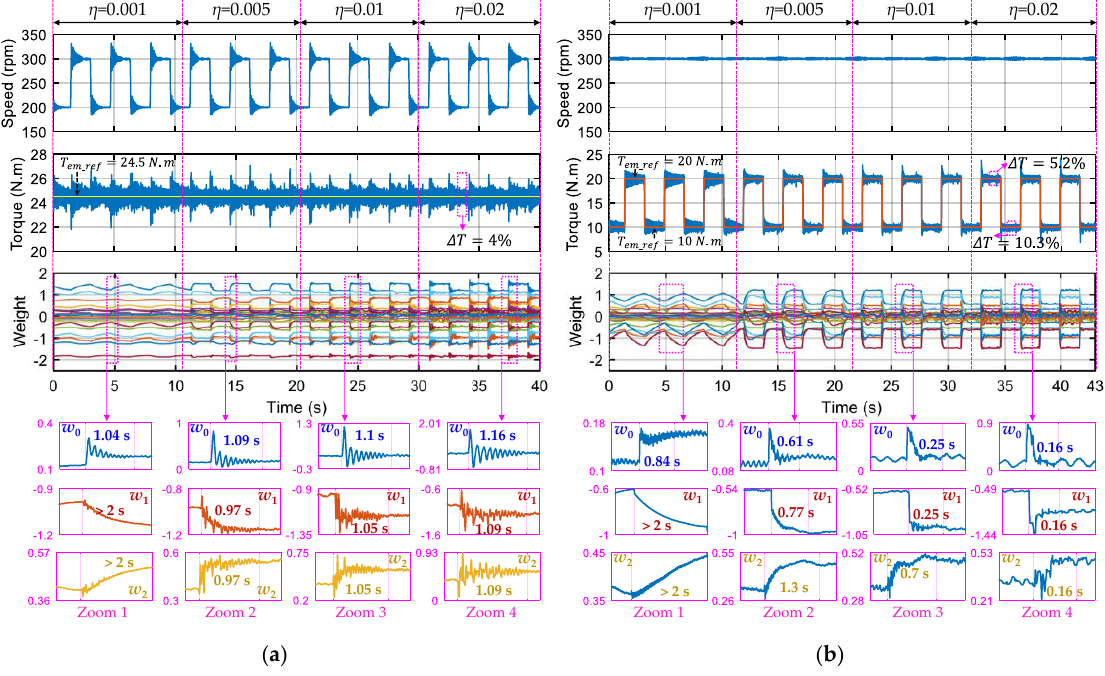
Figure 13. (Experimental result) Dynamic performance of the proposed control scheme using Ada- line_Fault and ECL strategy with four values of learning rate η when phase A is opened with: ( a ) rotating speed variations; and ( b ) reference torque variations.